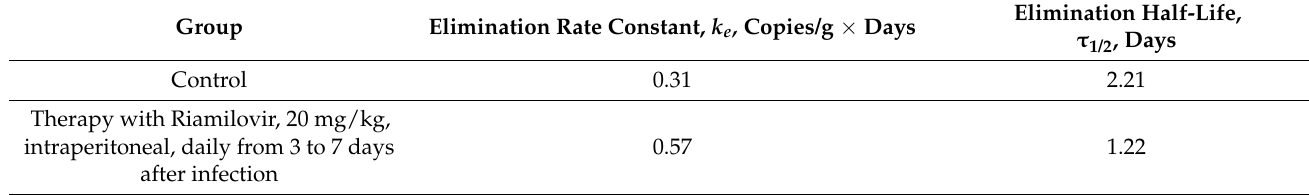
Table 1. Elimination rate and elimination half-life of virus from lung tissue in female Syrian hamsters treated with Riamilovir (Triazavirin), 20 mg/kg, intraperitoneal, daily from 3 to 7 days after infection with SARS-CoV-2 (4.25 × 104 TCID50/mL) in dosage 26 µ L/animal, intranasal. Adapted/Translated from Russian to English under the CC BY 3.0 license from Chepur, S.V., 2021 [76].